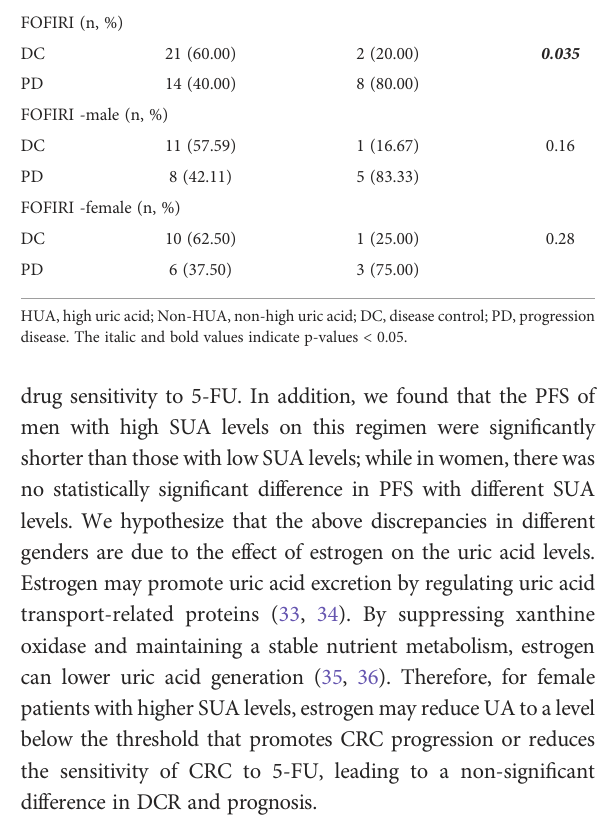
TABLE 3 Relationship between SUA levels and disease control rate in patients using FOLFIRI following colorectal cancer surgery. Non-HUA HUA